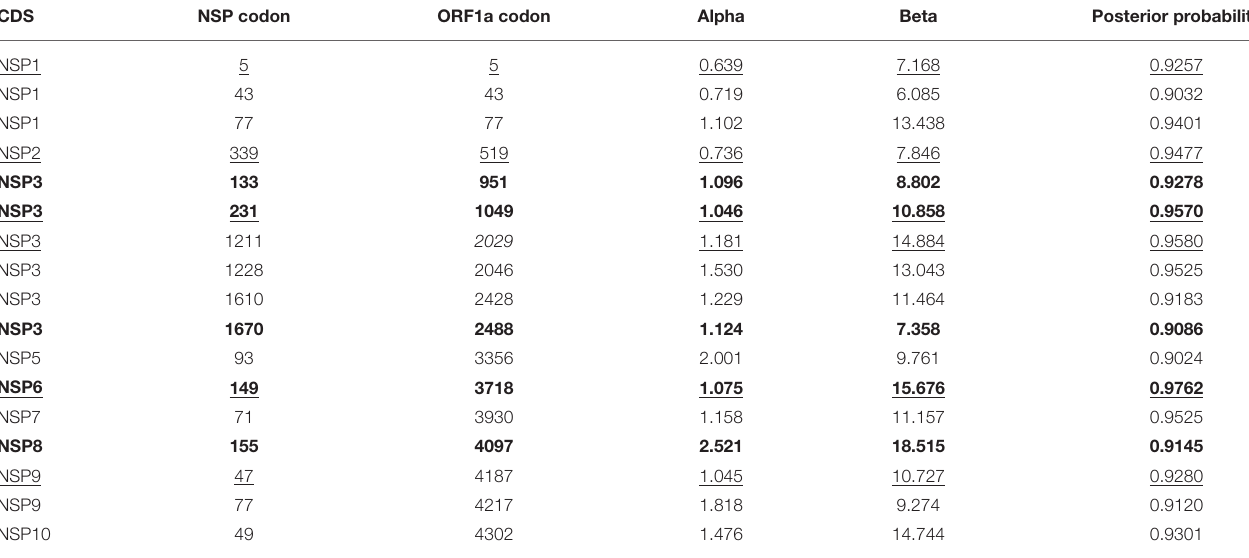
TABLE 5 | Fast Unbiased AppRoximate Bayesian (FUBAR) analysis of pervasive diversifying selection on non-structural proteins (NSPs) from